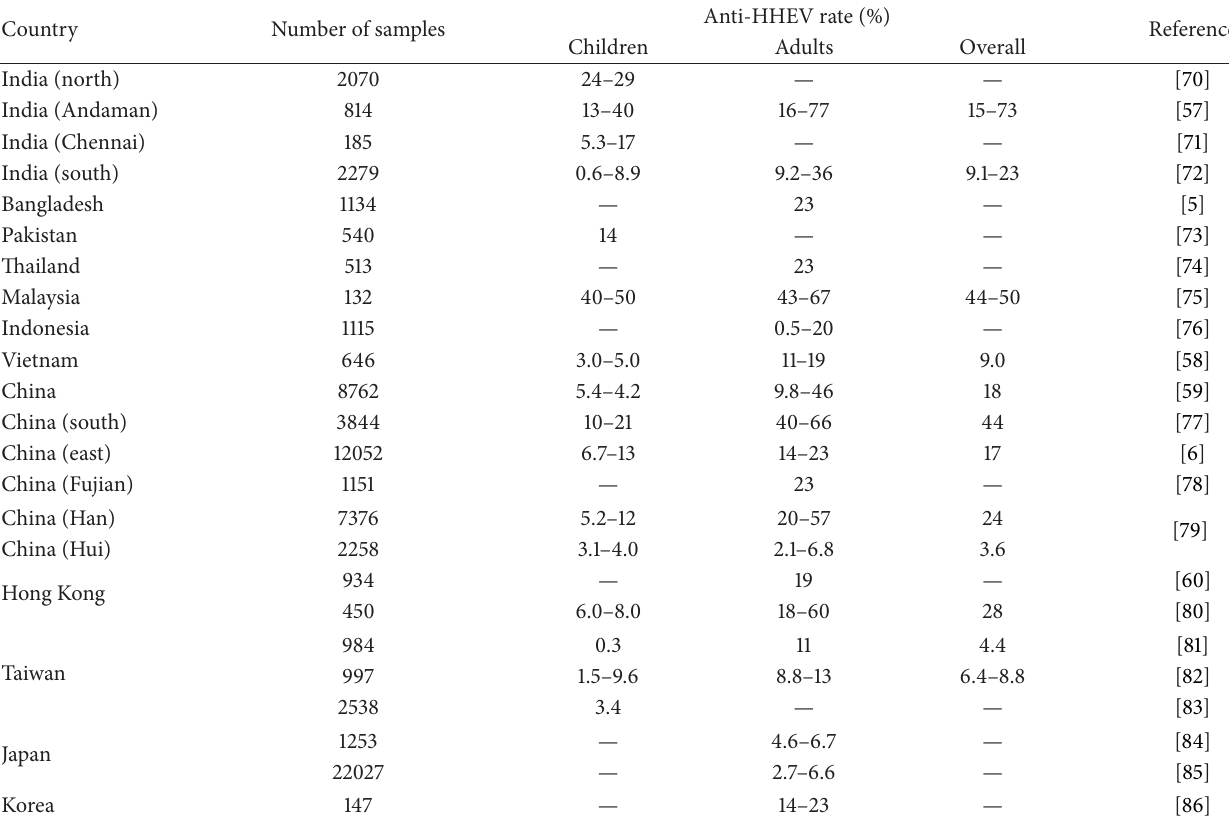
Table 2: Prevalence of anti-HHEV among the general population of South Asia and the Far East.